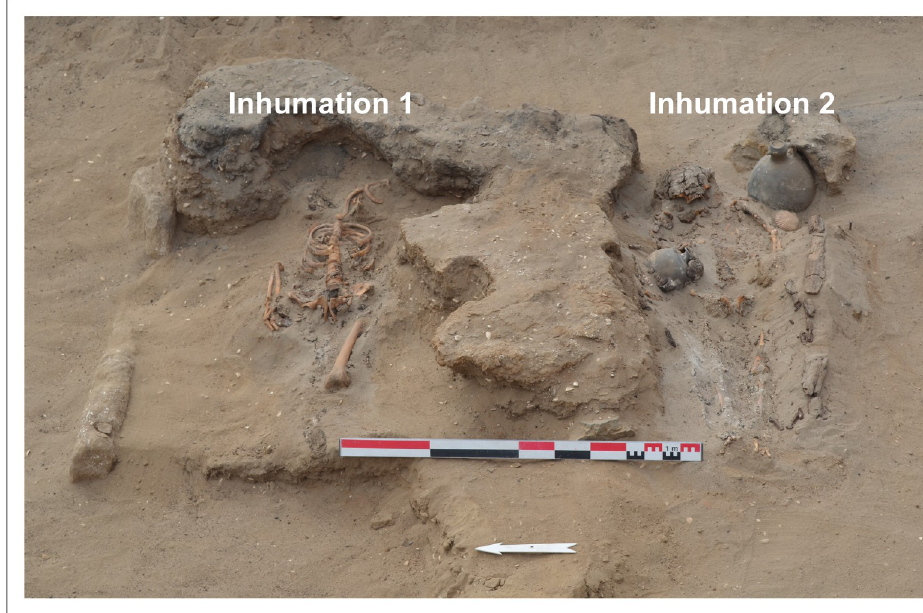
Fig 5. View of the two burials located at the top of the archaeological sequence of area A4.3.